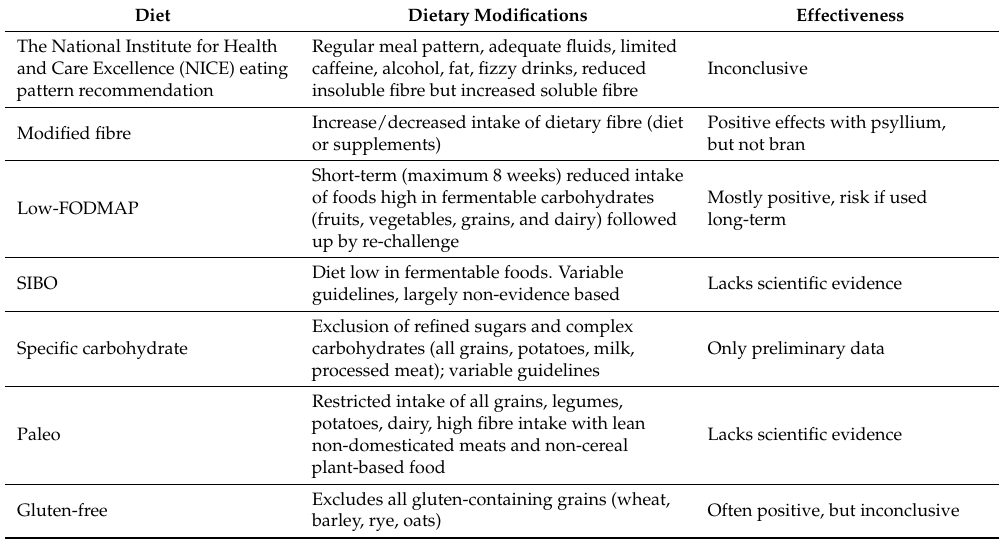
Table 2. Summary of evidence on dietary modifications in inflammatory bowel syndrome (IBS), adapted from Tuck and Vanner, 2016 [99]. FODMAP: fermentable oligo-, di-, and monosaccharides, and polyols; SIBO: small intestinal bacterial